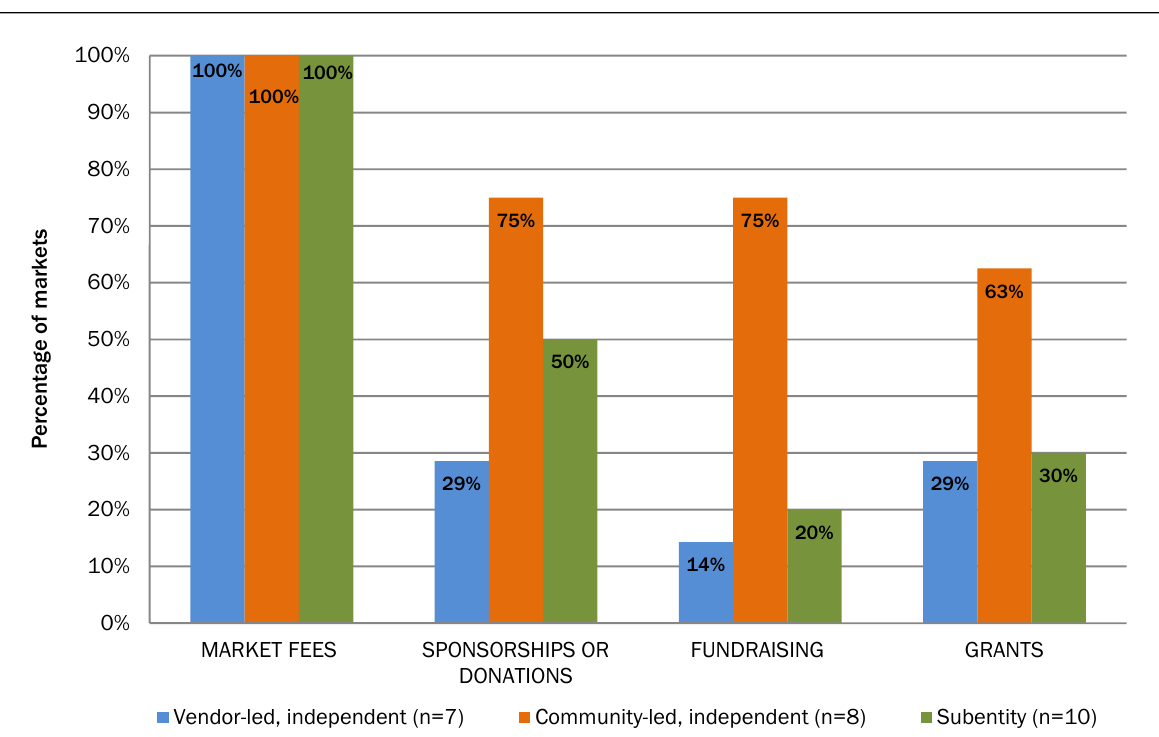
Figure 1. Sources of Financial Support (Percentage of Markets Using Each Revenue